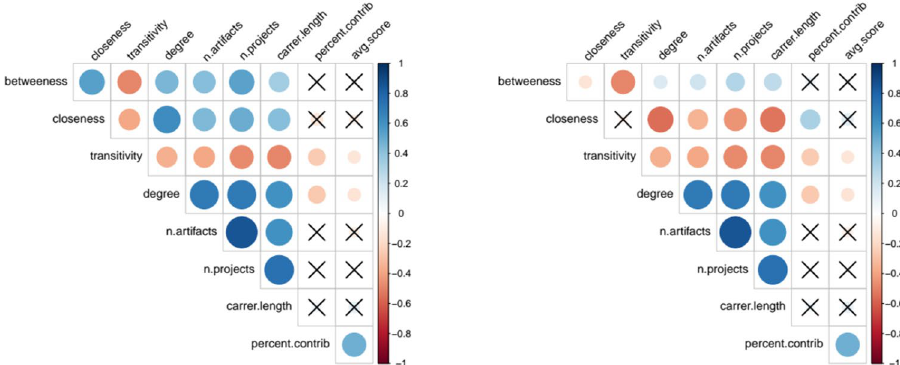
Figure 3. Correlation matrix for the NECTEC researchers network. Blue indicates positive correlation and red indicates negative correlation. Color intensity indicates the strength of correlation. Insignificant coefficients, according to p value p = 0.001 , are marked with a cross. On the right, betweenness and closeness centrality have been normalized by degree centrality.